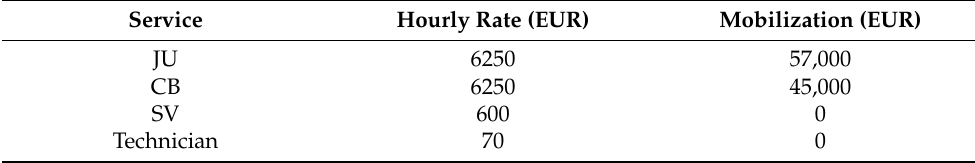
Table 9. Hourly rates and mobilization costs.